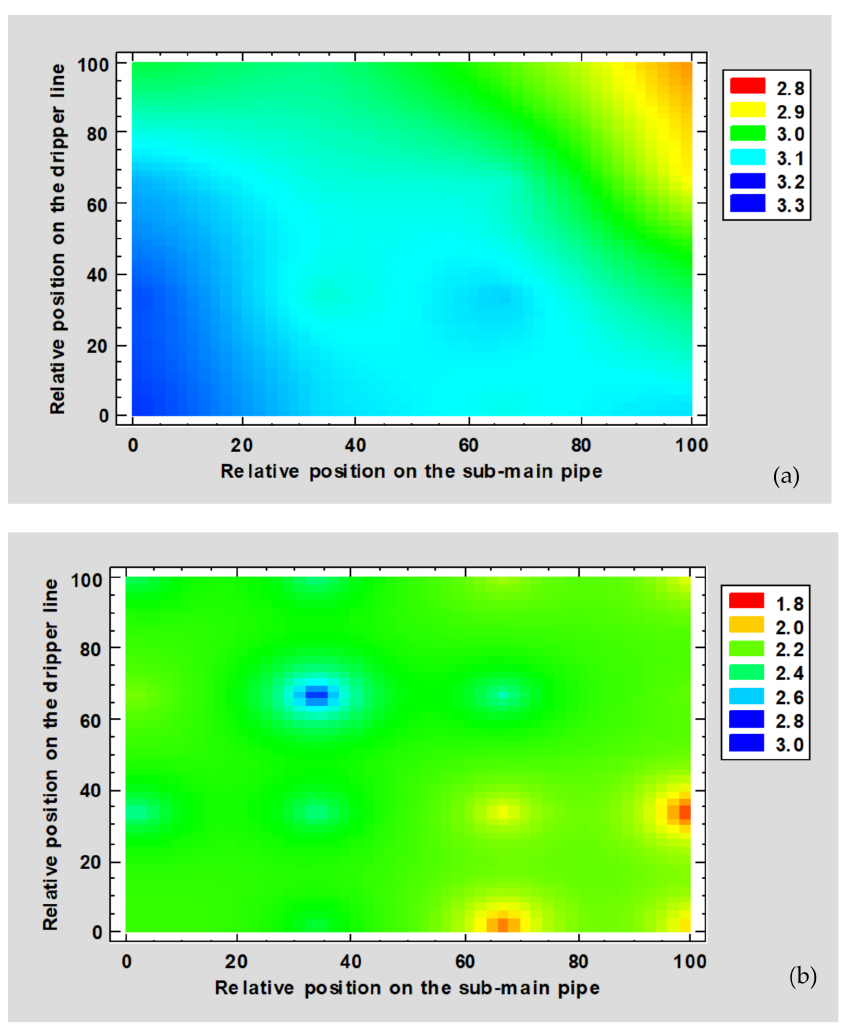
Figure 5. Kriging map for distribution of irrigation water (mm) in two dimensions in conven- tional/integrated ( a ) and organic ( b ) production systems of the greenhouses of Almer í a, where 0 corresponds to of the dripper line or sub-main pipe and 100 corresponds to the last emitter of the dripper line or sub-main pipe. Exponential adjustment with R 2 = 96.70%, root mean square error (RMSE) = 0.00122, and p ≤ 0.05 for ( a ), and R 2 = 79.65%, root mean square error (RMSE) = 0.01879, and p ≤ 0.05 for ( b